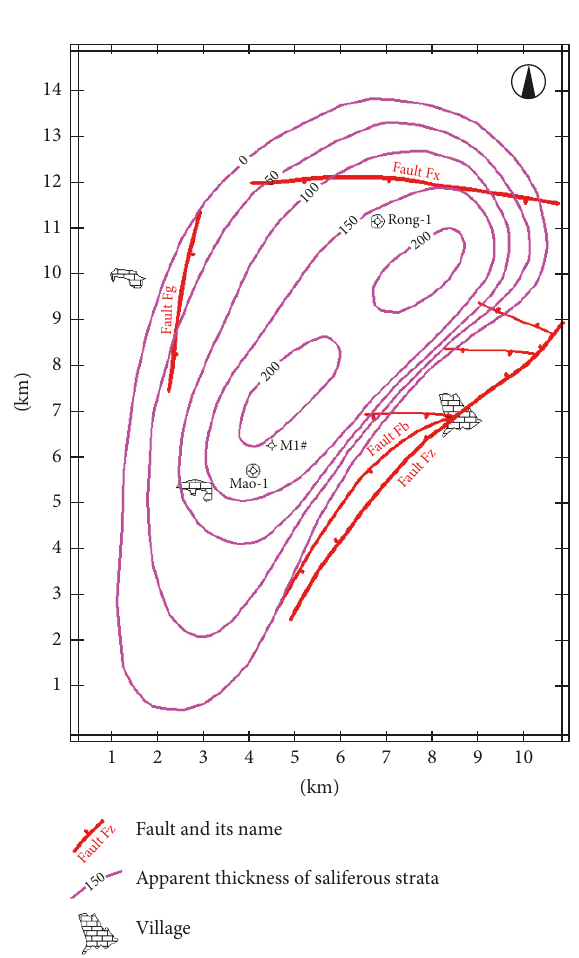
Figure 3: Tectonic map and thickness of saliferous strata of Jintan salt